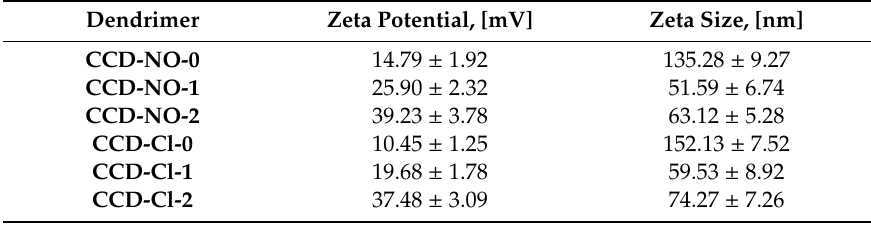
Table 2. Zeta potential and zeta size of copper metallodendrimers with nitrate and chloride surface groups.